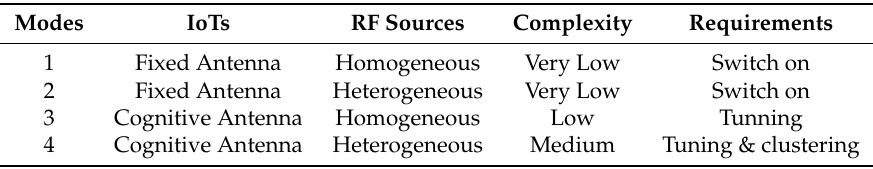
Table 2. Operational